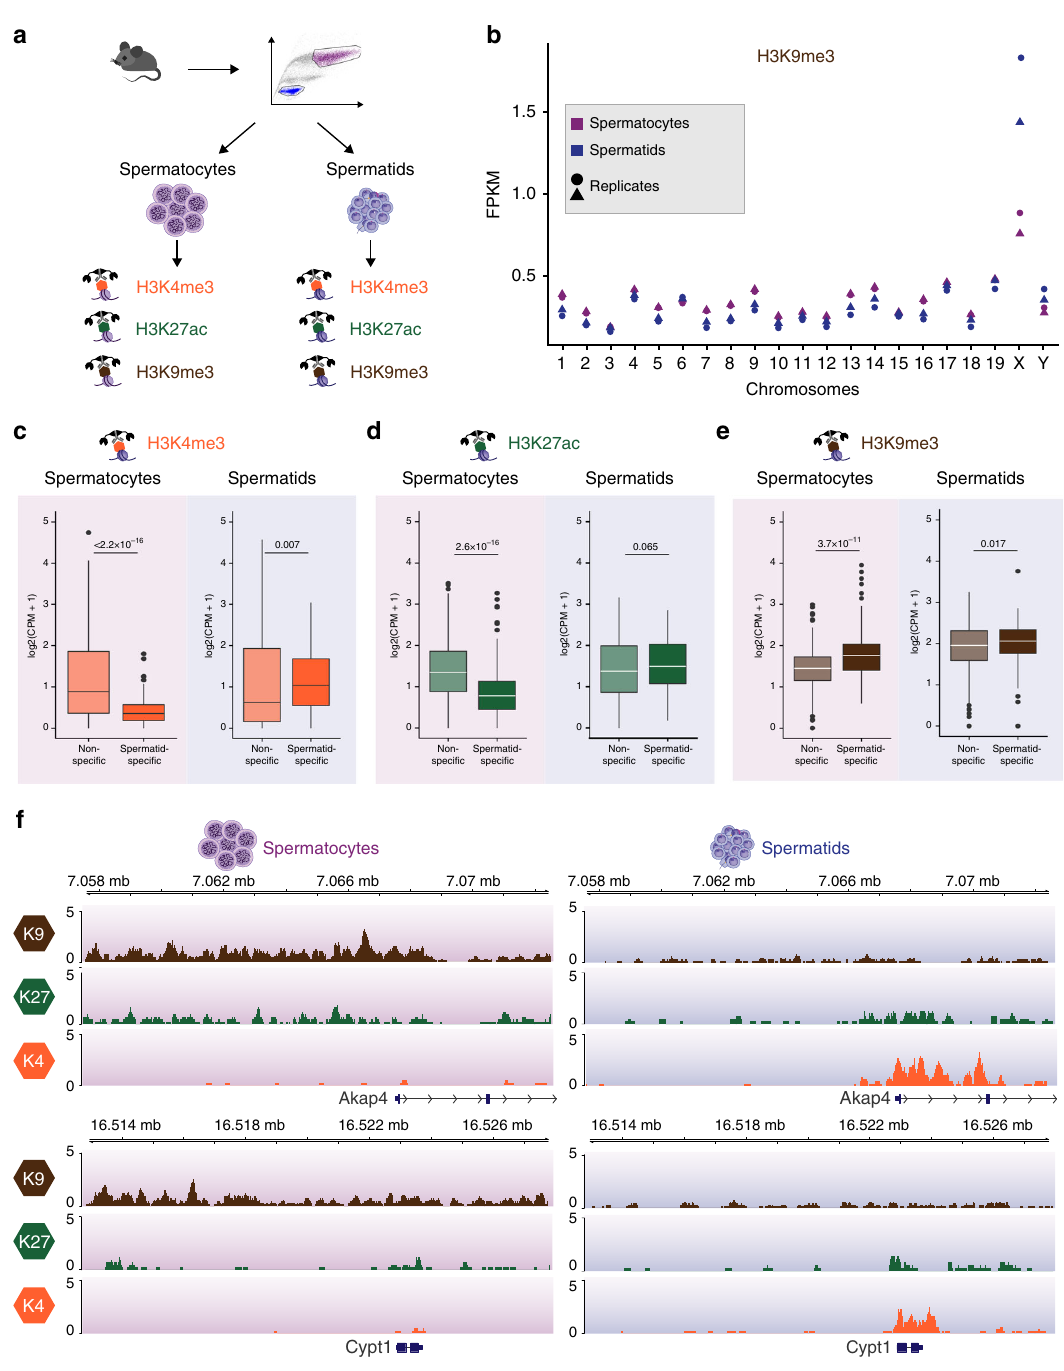
Fig. 8 Epigenetic changes associated with X chromosome in- and re-activation. a Spermatocytes and spermatids were isolated from the same individual using FACS and pro fi led using H3K4me3 (active mark), H3K27ac (enhancer mark) and H3K9me3 (repressive mark) using CUT&RUN (Supplementary Fig. 10A and Methods). b Number of H3K9me3 Fragments Per Kilobase per Million (FPKM) for each chromosome. Pink (spermatocytes); Blue (spermatids). Shape corresponds to biological replicate at the P26 time-point. c – e Boxplot of H3K4me3 ( c ), H3K27ac ( d ) and H3K9me3 ( e ) Counts Per Million (CPM) in promoter regions of spermatid speci fi c ( n = 128) and non-spermatid speci fi c ( n = 622) genes for spermatocytes (left) and